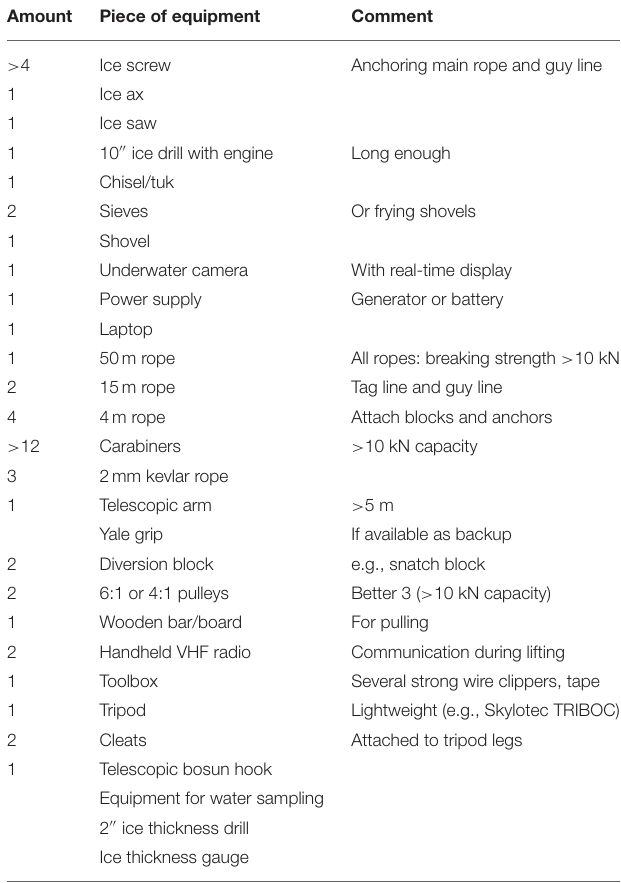
TABLE 1 | Suggested list of equipment for profiler